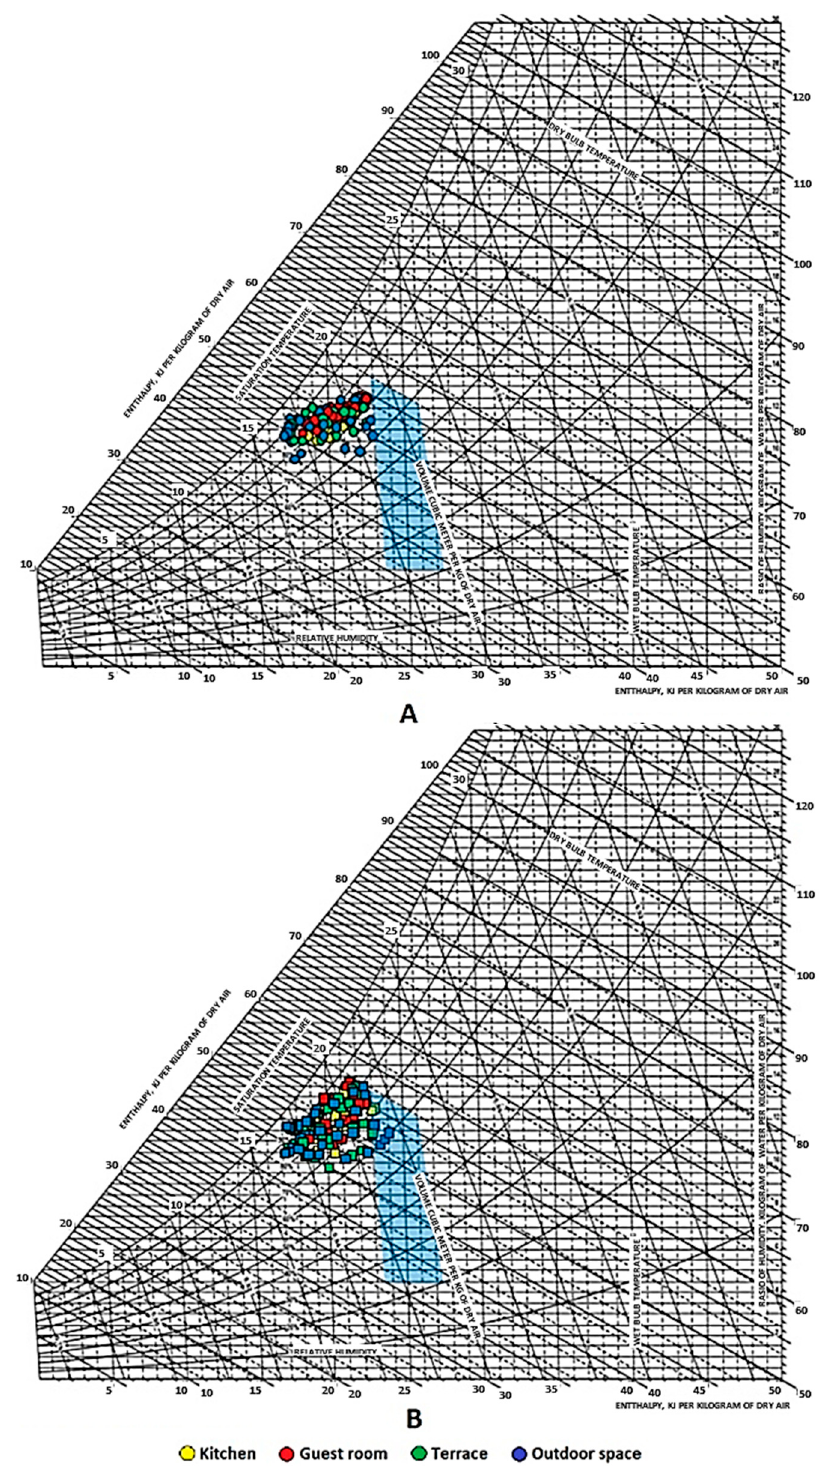
Figure 13. The psychrometric diagrams for exposed stone houses ( A ) and wooden houses in the mountains, ( B ).